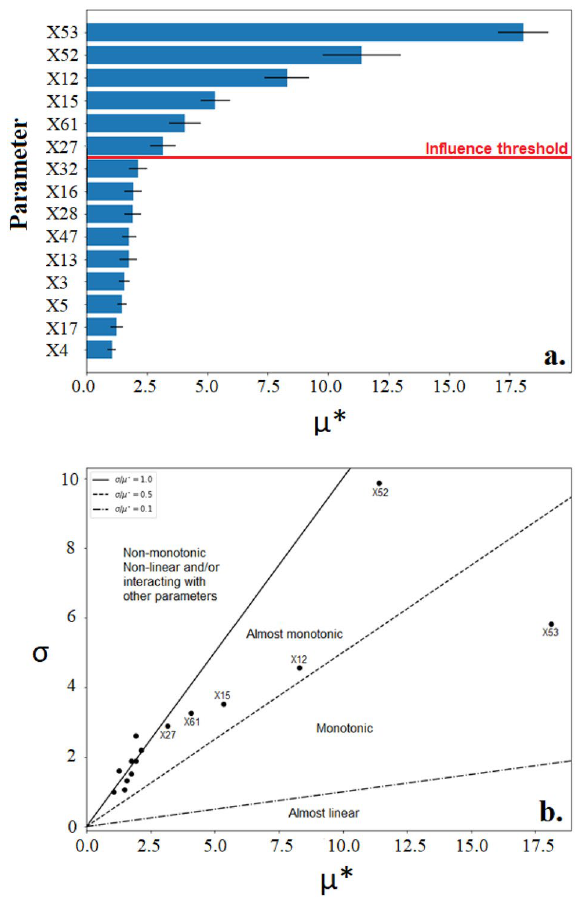
Figure 3. ( a ) The 15 parameters of greatest influence on the TN output as demonstrated by the MoM displayed by ( a ) A horizontal bar chart with influence threshold 0.1 and ( b ) a Morris plot